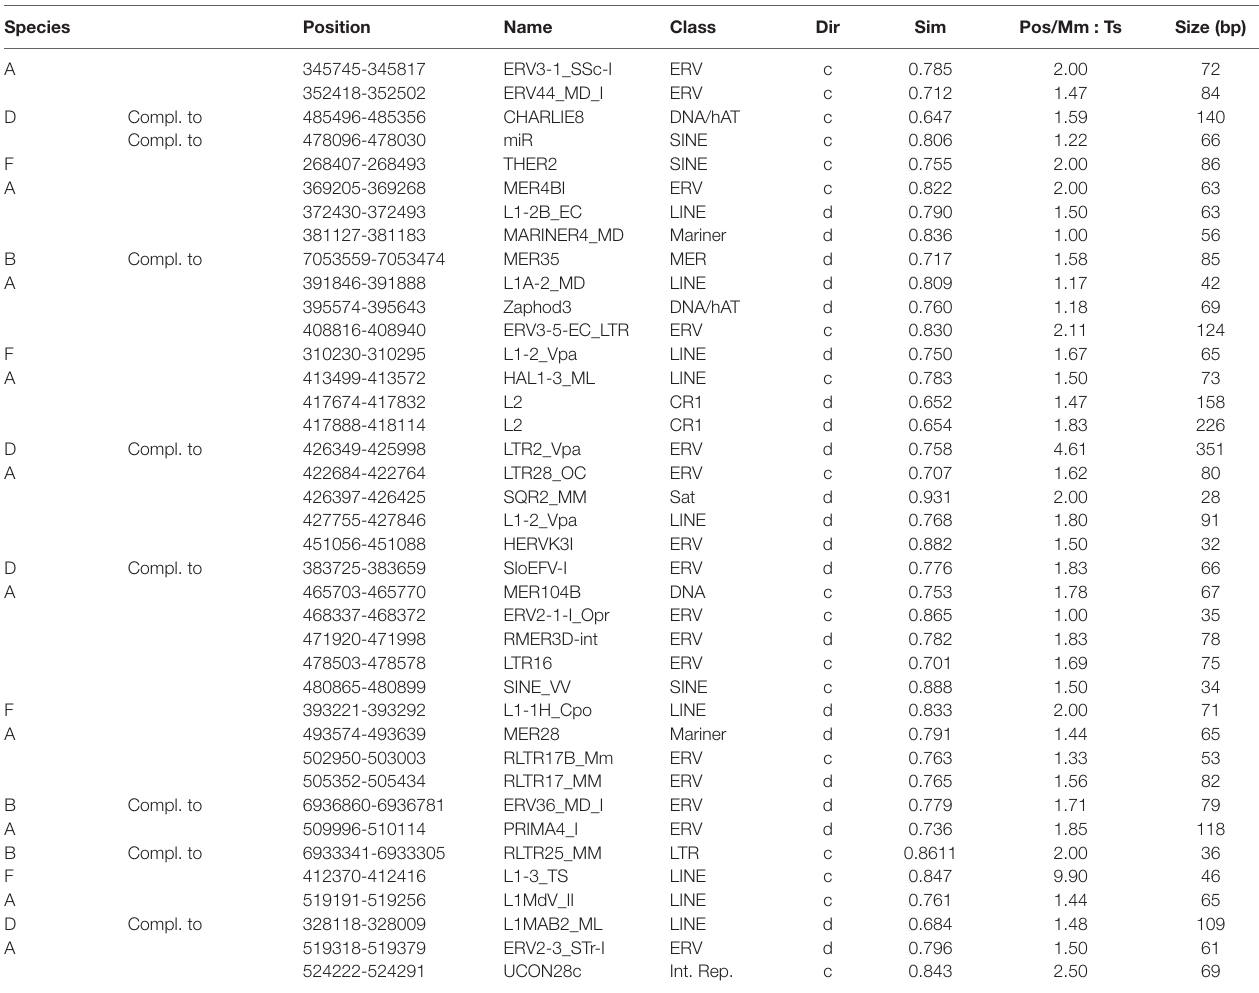
TABLE 5 | Species-specific interspersed elements found by the comparative genomic analysis of the casein cluster in camelids (A, alpaca; B, Bactrian; D, dromedary; F, feral camel) and listed in order 5’ > 3’ as they appear in the cluster. Repbase was used as repeat database. Positions are indicated according to the corresponding GenBank sequence (wild feral: AGVR01039100.1; Bactrian: NW_011517196.1; dromedary: NW_011591251; alpaca: KN269544). The direction of the repeat fragment is indicated as d = direct or c = complementary; Sim, similarity with repeat element in the database; and Pos/Mm, Ts column is a ratio of mismatches to transitions in nucleotide alignments. The closer Pos/Mm, Ts number is to 1 the more likely is that mutations are evolutionary. Species